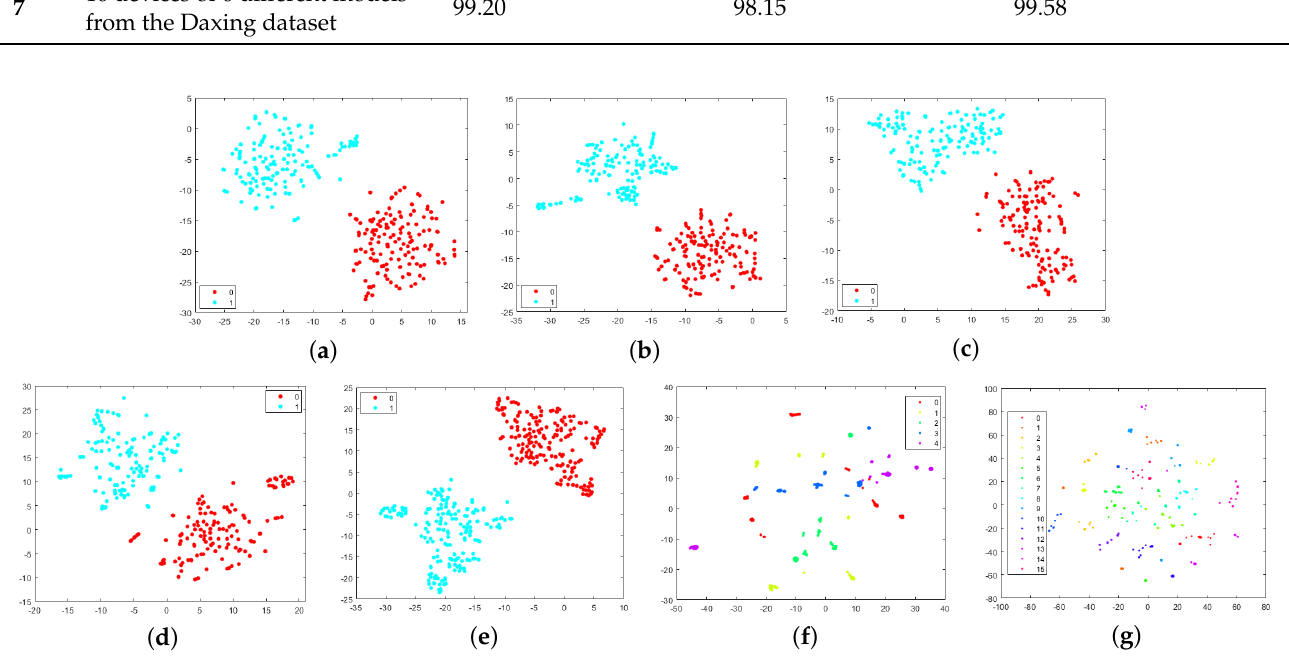
Figure 3. Results obtained with t-SNE on different datasets demonstrating the separation between different devices belonging to the same model: ( a ) two iPhone 5c devices, ( b ) two iPhone 4s devices, ( c ) two Fujifilm X-A10 devices, ( d ) two Redmi Note 3 devices, ( e ) two Asus Zenfone Max Pro M1 devices, ( f ) five Xioami 4A devices, and ( g ) 16 devices of 6 different models from the Daxing